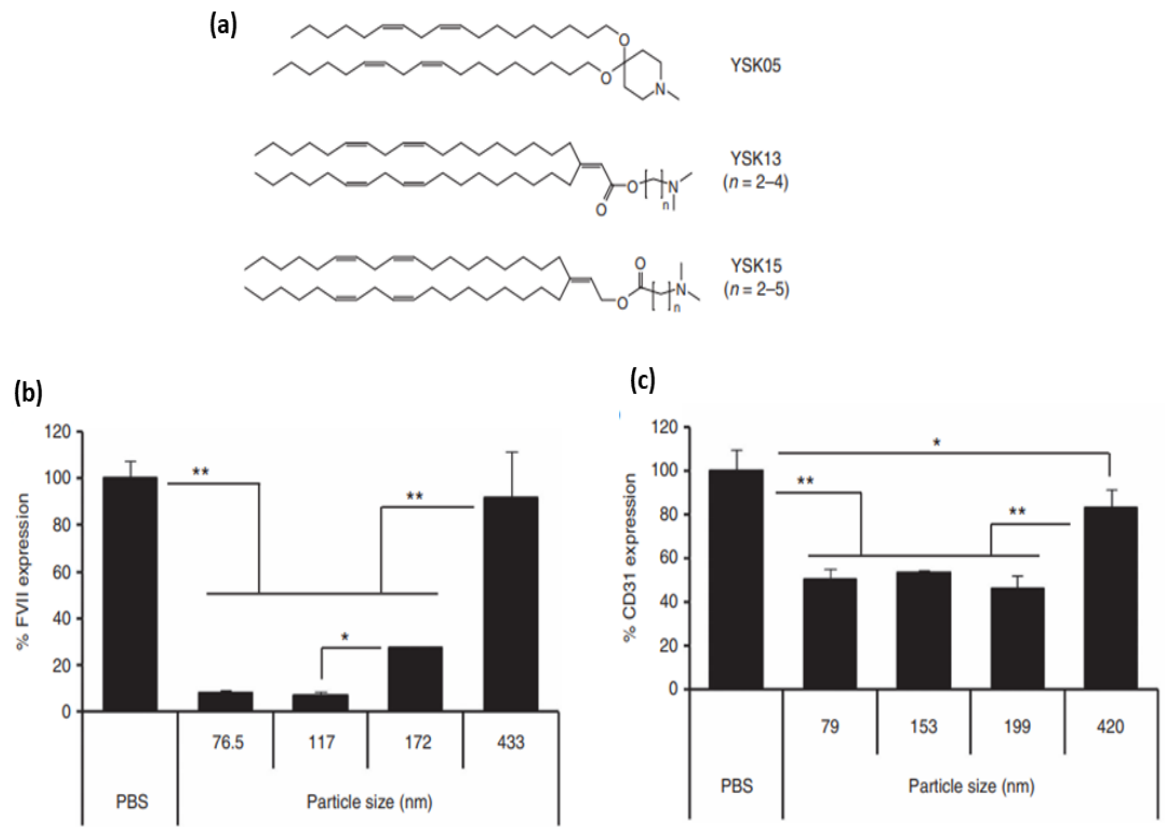
Figure 5. ( a ) Different cationic lipid structures. ( b ) Effect of size on the gene silencing activity in hepatocytes and LSECs. Mice were injected with siFVII formulated in various sizes of YSK13-C3- MENDs at a dose of 0.1 mg/kg and plasma FVII activities were measured in 24 h ( c ) Mice were injected with siCD31 formulated in various sizes of YSK15-C4-MENDs at a dose of 0.1 mg/kg and quantification of CD31 mRNA expression on LSECs in 24 h. Data are represented as the mean ± SD (n = 3). *P < 0.05, **P < 0.01 (by one-way nrANOVA, followed by SNK test. nrANOVA ,non-repeated analysis of variance; SNK, Student-Newman-Keuls. Adapted from ref. [114], Mol. Ther. 2016.